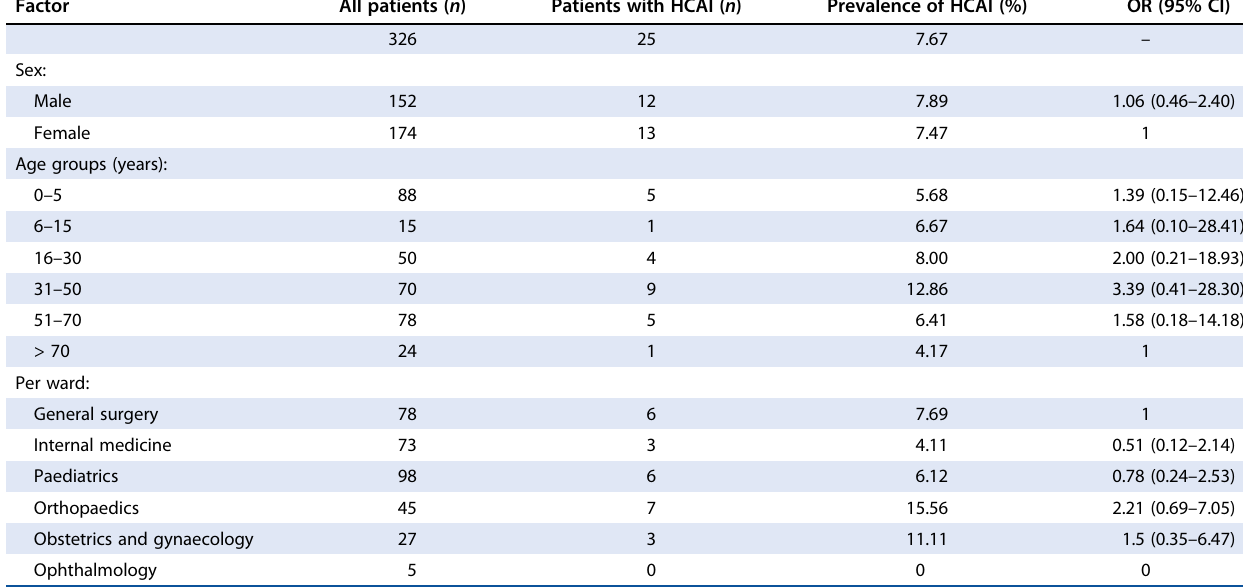
Table 1: Point prevalence of healthcare-associated infections according to patient characteristics Factor All patients ( n ) Patients with HCAI ( n )